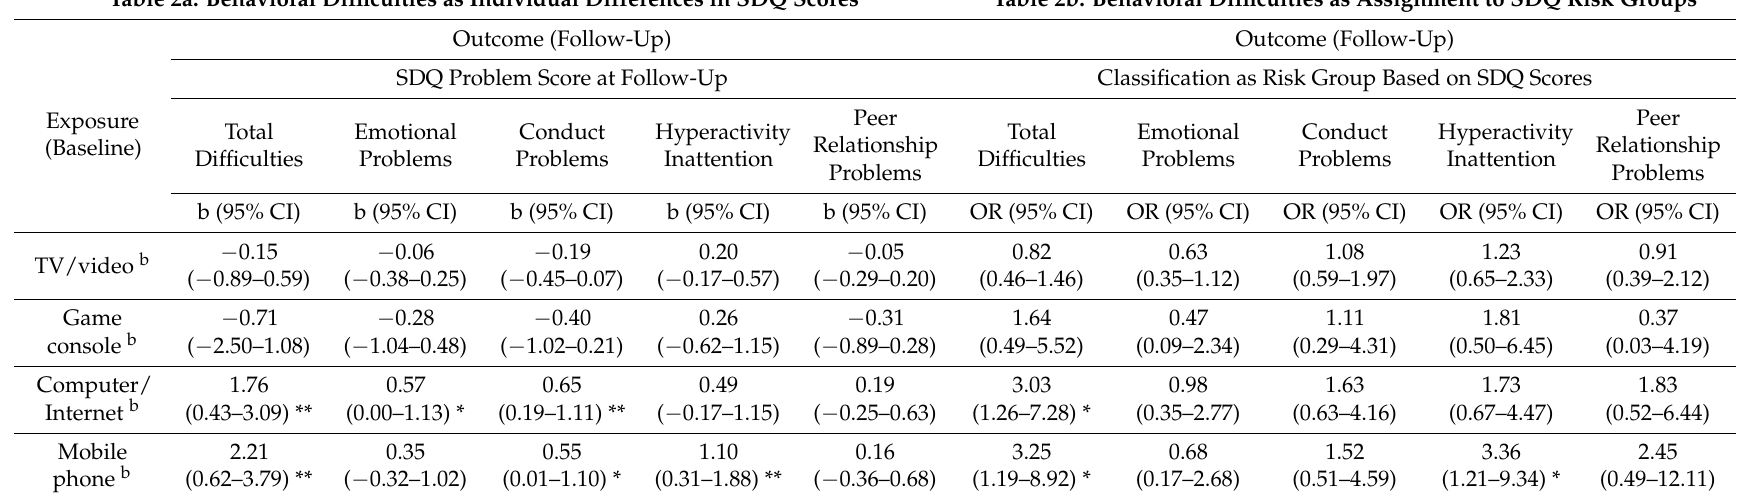
Table 2. Association of electronic media usage at baseline with behavioral difficulties at follow-up (N = 537) a . Table 2a. Behavioral Difficulties as Individual Differences in SDQ Scores Table 2b. Behavioral Difficulties as Assignment to SDQ Risk